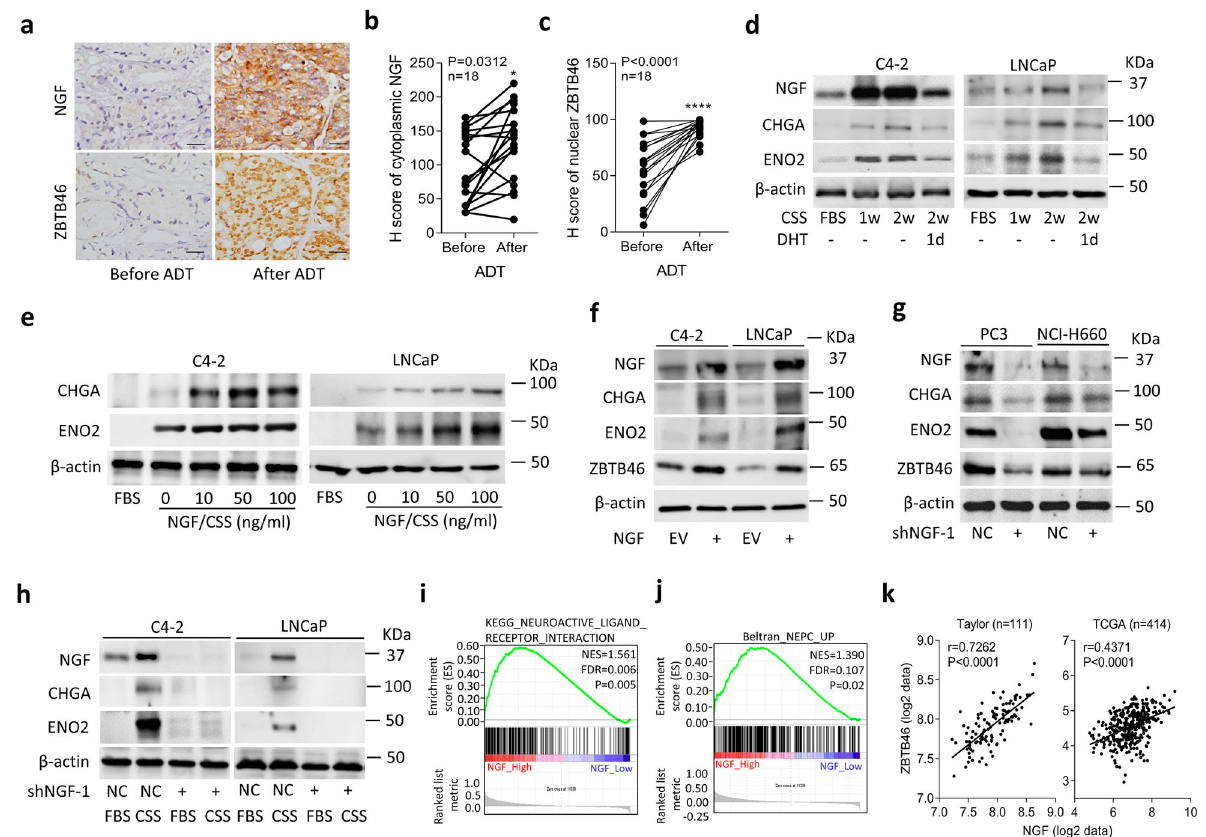
Fig. 3 ADT-upregulated NGF is associated with NEPC. a – c IHC staining ( a ) and analysis ( b and c ) of cytoplasmic NGF and nuclear ZBTB46 in prostate cancer tissue sections from patients before and after ADT. The 18 samples were collected from Taipei Medical University-Wan Fang Hospital. Scale bars, 100 µ m. Statistical analysis was performed using a two-tailed Student ’ s t -test. * p < 0.05, **** p < 0.0001. d Western blotting of the NGF, CHGA, and ENO2 in C4-2 and LNCaP cells cultured in charcoal stripped serum (CSS)-containing medium for 1 and 2 weeks, followed by treatment with 10 nM dihydrotestosterone (DHT) for 1 day. e Western blotting for CHGA and ENO2 in C4-2 and LNCaP cells treated with the NGF protein in CSS-containing medium at various concentrations for 1 week. Fetal bovine serum (FBS)-containing medium without the NGF protein served as the control. f Western blotting for NGF, CHGA, ENO2, and ZBTB46 in C4-2 and LNCaP cells stably transfected with an empty vector (EV) or NGF expression vector. g Western blotting for NGF, CHGA, ENO2, and ZBTB46 in PC3 and NCI-H660 cells stably expressing a non-target control (NC) or NGF shRNA vector. h Protein levels of the NGF, CHGA, and ENO2 in NGF-knockdown C4-2 or LNCaP cells and cells treated with CSS-containing medium for 1 week. i , j GSEAs of TCGA prostate cancer dataset showing that high NGF expression levels in prostate tissues were positively associated with a neuronal development signature (KEGG) ( i ) and a NEPC-respons i ve gene signature 25 ( j ). NES normalized enrichment score, FDR false discovery rate. k Correlation analysis of NGF with ZBTB46 mRNA levels in clinical tissue samples from the Taylor and TCGA prostate cancer datasets. Signi fi cance was determined by a two-way